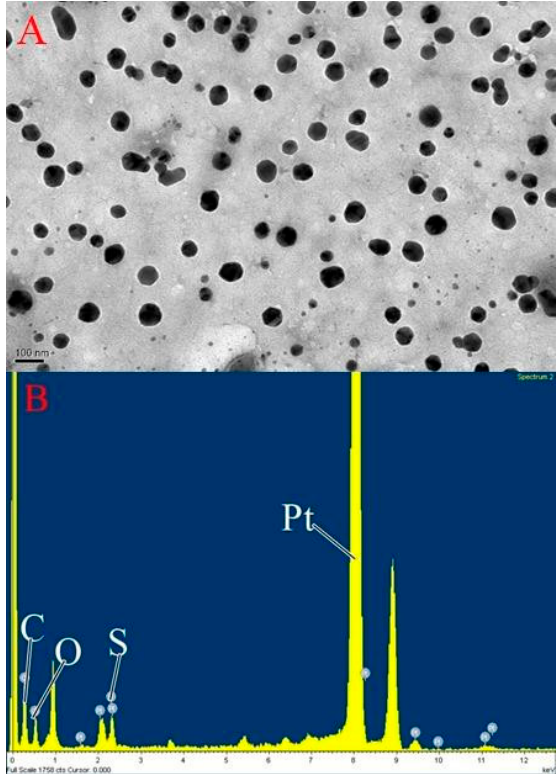
Figure 1. ( A ) Transmission electron microscopy (TEM) image of Fu100Cis20 nanoparticles; ( B ) Corresponding energy-dispersive X-ray spectroscopy spectrum.